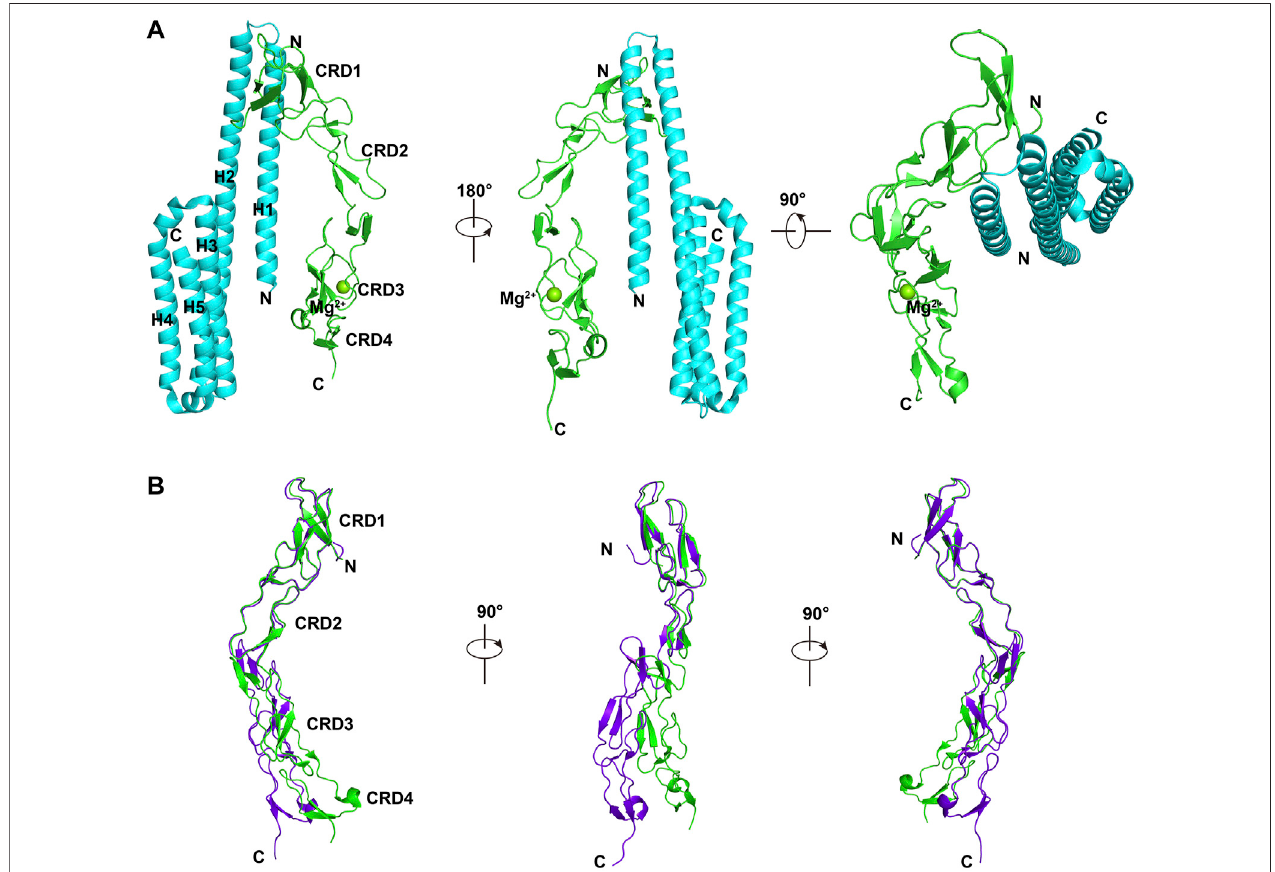
FIGURE 2 | Complex structure between DR6-CRDs and APP-E2 (PDB ID:4YN0) (A) . APP-E2 domain is colored in cyan, and CRDs of DR6 are colored in green. (B) . Structural comparison between monomeric DR6-CRDs (purple) and the DR6-CRDs (green) from DR6-CRDs:APP-E2 complex.